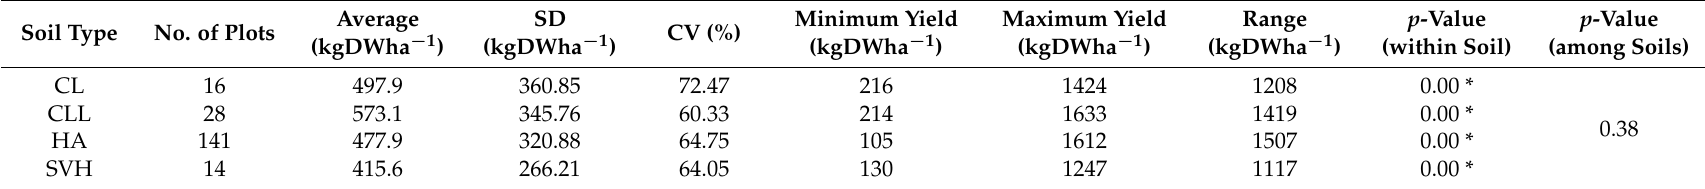
Table 4. Comparison of yield variation according to soils.